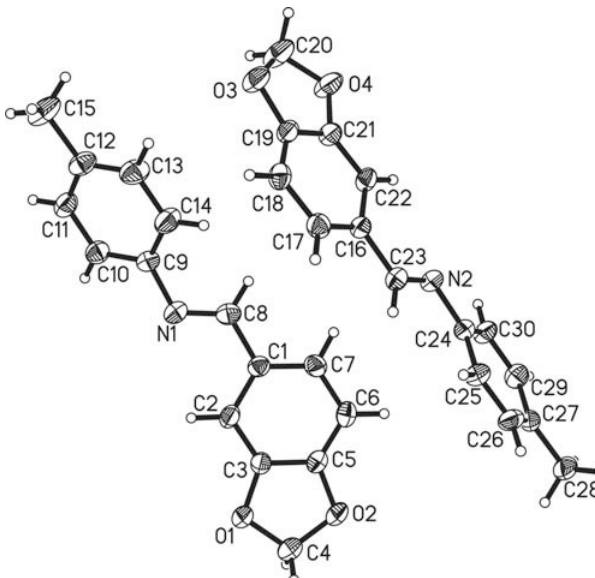
Table 2. Atomic coordinates and displacement parameters (in Å 2 )